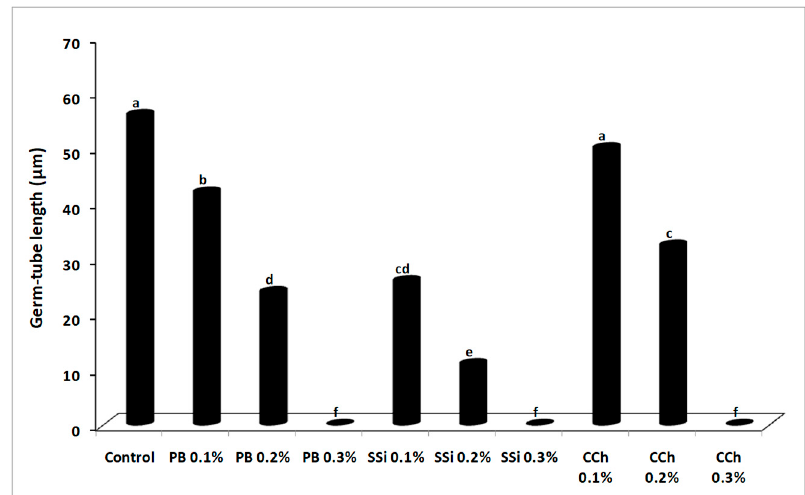
Figure 5. Effect of potassium bicarbonate (PB), sodium silicate (SSi), and calcium chelate (CCh) on conidial germination (%) of Botrytis cinerea in potato dextrose broth after 8 h of incubation at 23 ± 1 °C. Values marked with the same letters are not statistically different by Fisher’s protected least significant difference test at p ≤ 0.05.